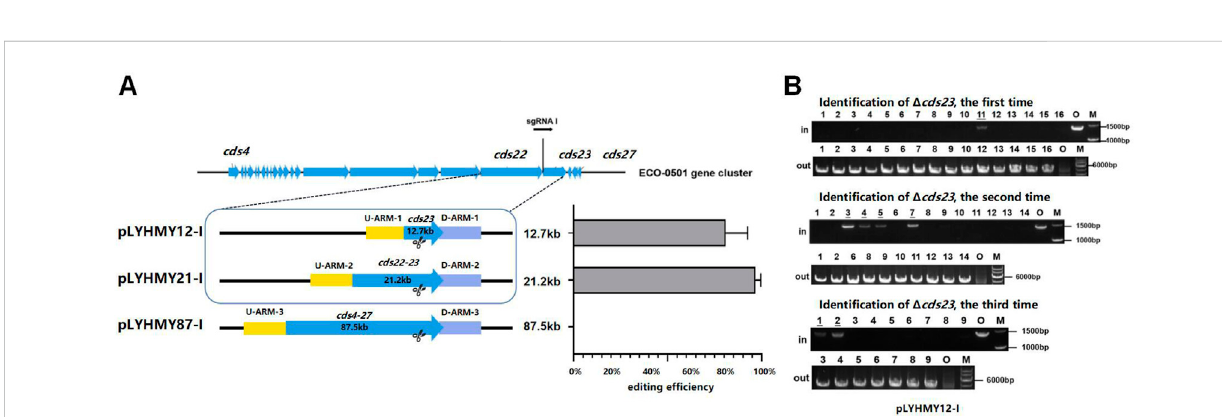
FIGURE 4 Thedeletingef fi cienciesofthesamesgRNA expression cassetteondifferentsizeoffragments. (A) The deletingef fi ciencies of cds23,cds22-23 ,and cds4-27 obtained by the editing plasmids containing the same sgRNA1 expression cassette and different up/downstream homologous arms of target clusters. Error bars represented the standard deviations from three independent biological replicates. (B) PCR analysis of randomly selected colonies transformed with pLYHMY12-I veri fi ed the deletions of cds23 . The amplicons of 1481 bp were the product of the original strain and 5169 bp amplicons represented that cluster cds23 of colonies were deleted. The underline below the number indicated that the DNA fragments of the colonies had not been knocked out after the veri fi cation of Verify-12in-F/Verify-12in-R. M, GeneRuler 1 kb DNA Ladder (Thermo Scienti fi c). O, original strain A. keratiniphila HCCB10007. Lanes 1 – 16, colonies transformed by pLYHMY12-I with cds23- speci fi c